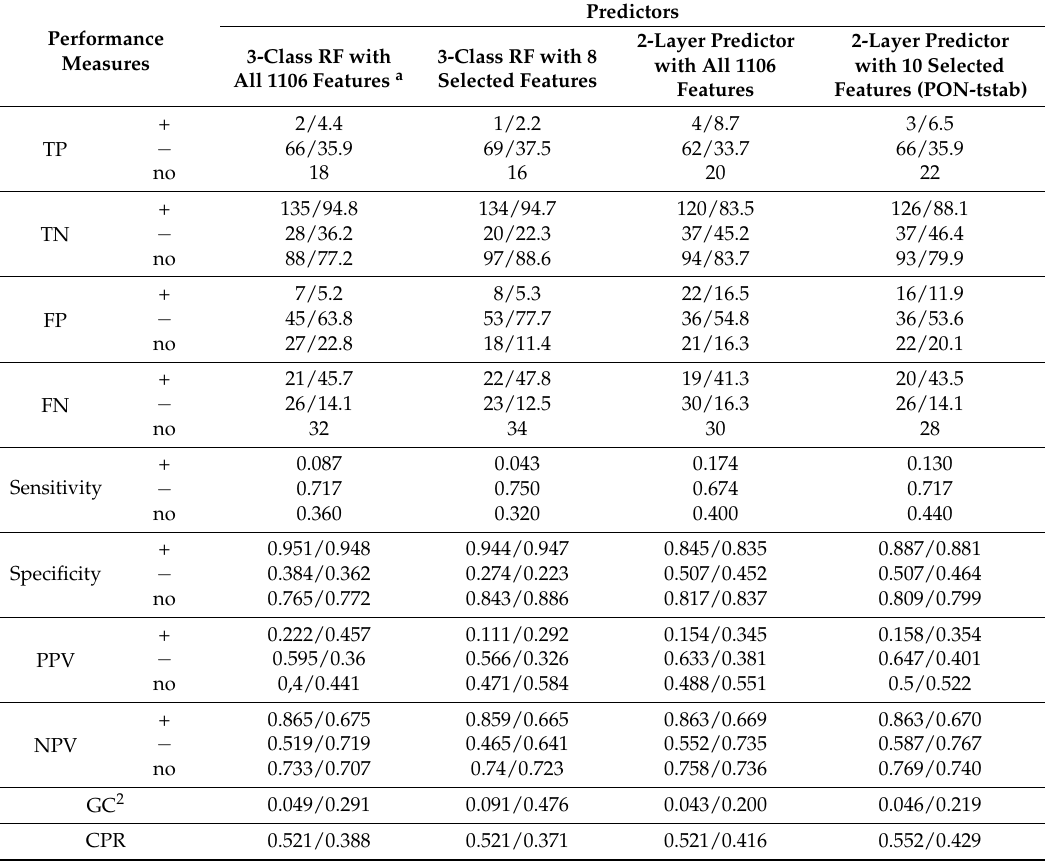
Table 2. Blind test